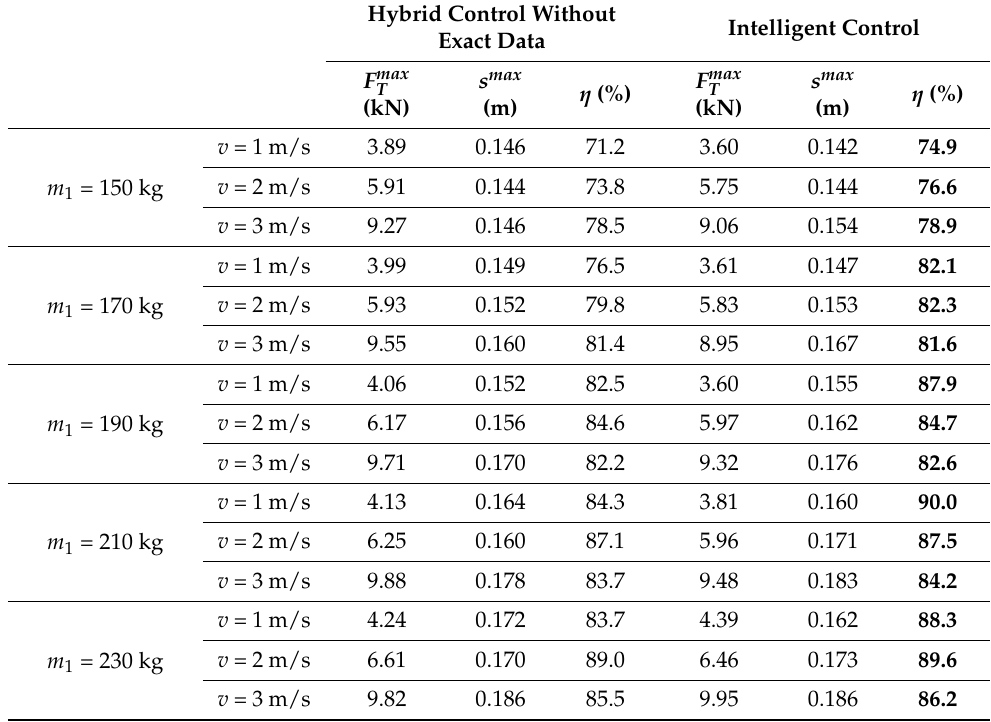
Table 5. Damper performance using real hybrid control without load cell sensor, and intelligent control in the testing cases. The best efficiency for each case is marked in